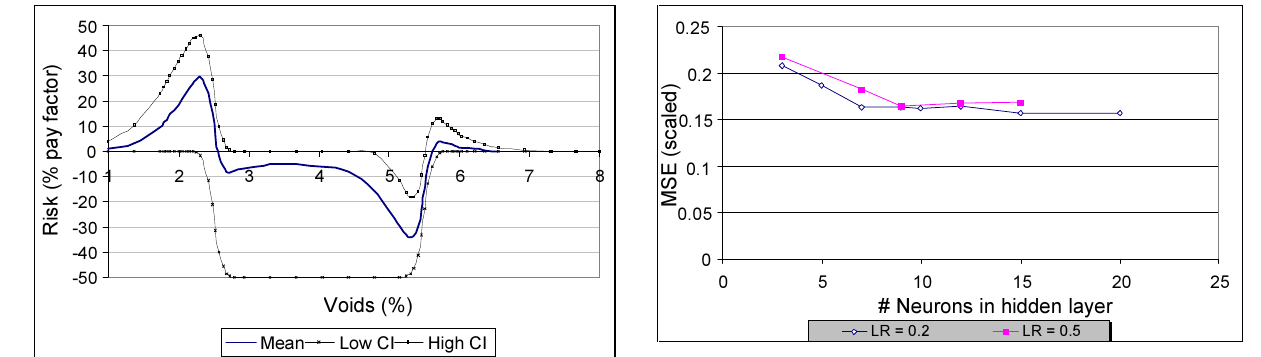
Fig. 2. Typical risk plot